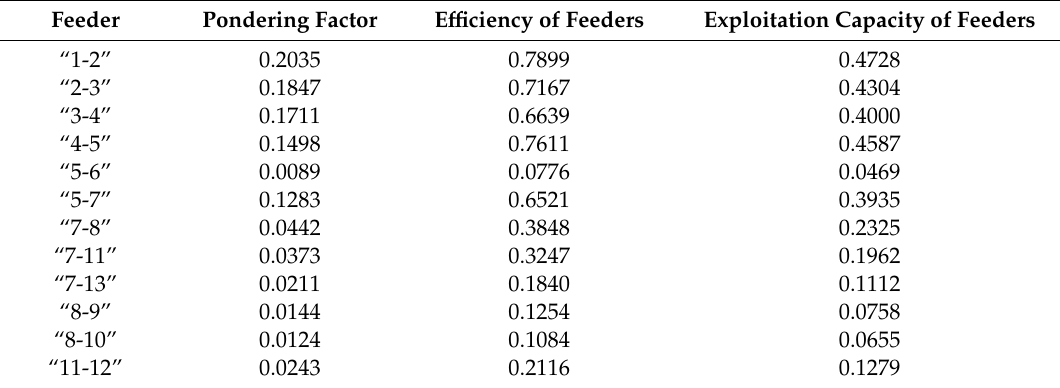
Table 5. Results of the validation process for case